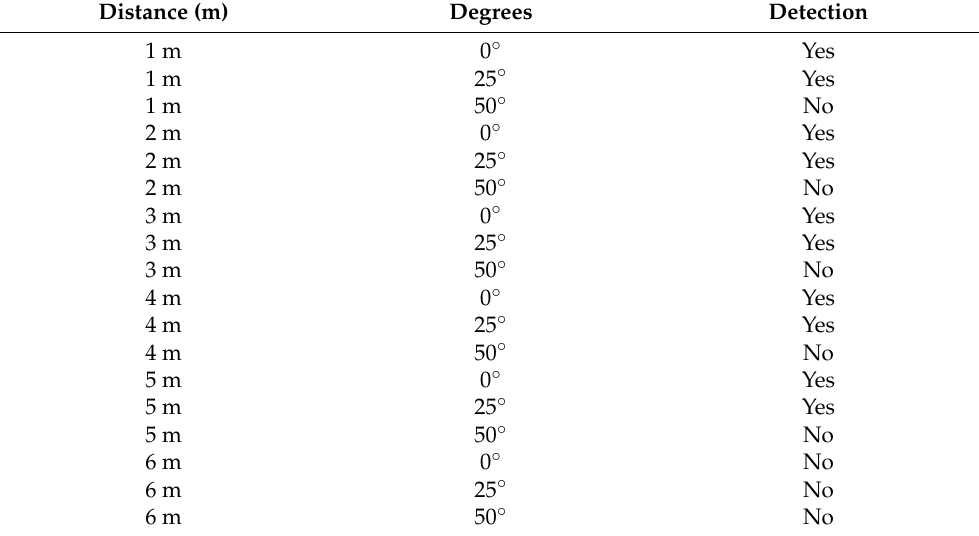
Table 7. Presence Sensor.